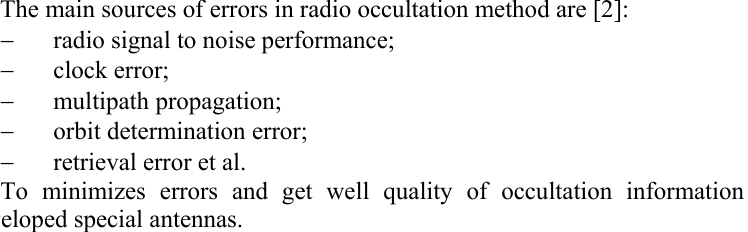
Fig 1. The schema of radio occultation